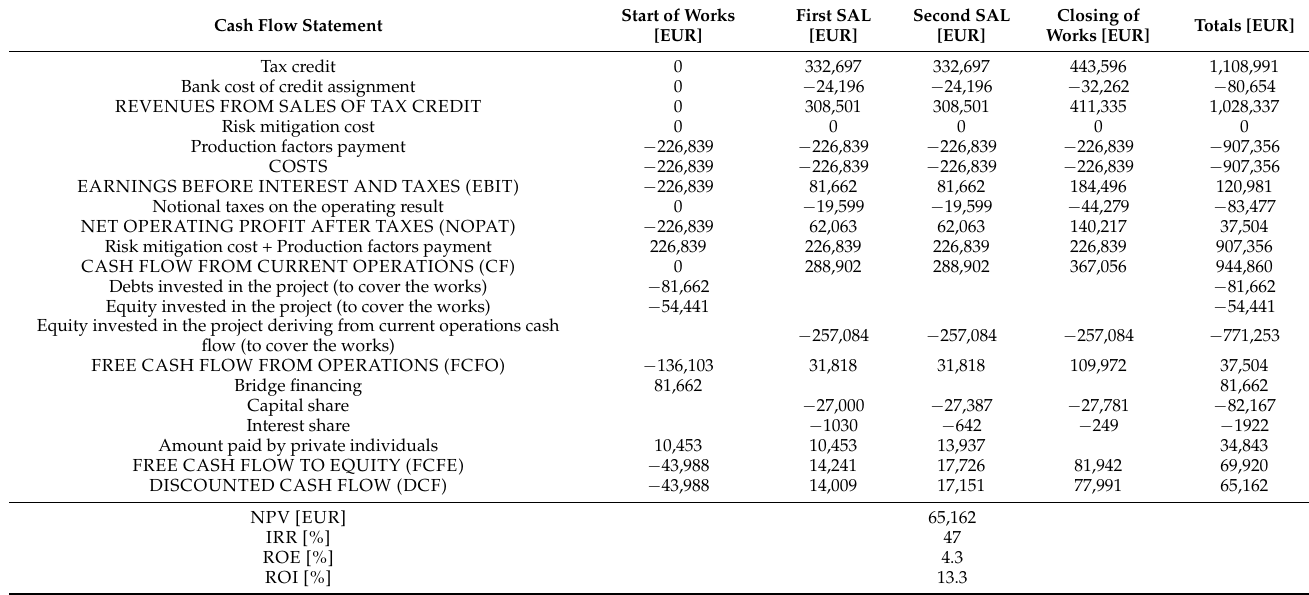
Table 9. Cash flow statement of the project in the case in which criticality levels similar to those found on small real estate units are assumed (with the most probable cost of mitigation of criticalities).